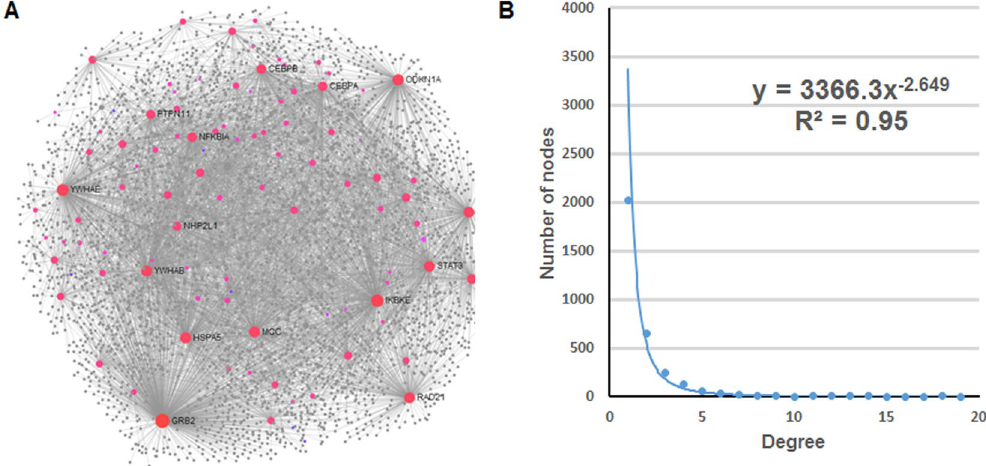
Figure 2. The visualization of KSHV miRNA-regulated CePPIN. ( A ) MiRNA-regulated CePPIN generated by Network Analyst. Red nodes are miRNA targets and grey nodes are non-targets. The 16 nodes in bigger size and with labels have the highest degrees in CePPIN. ( B ) Degree distribution of proteins in